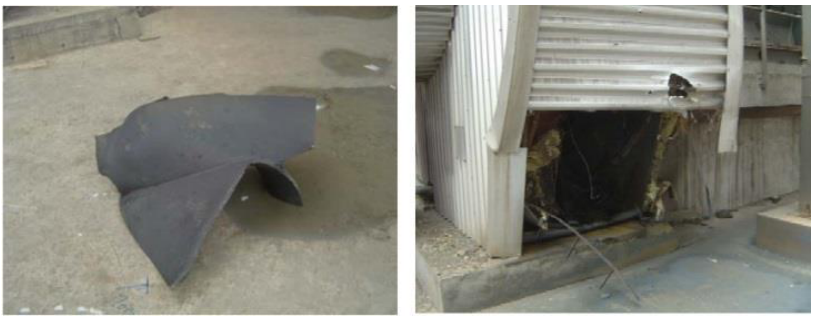
Figure 4. Site photos of the broken blade.